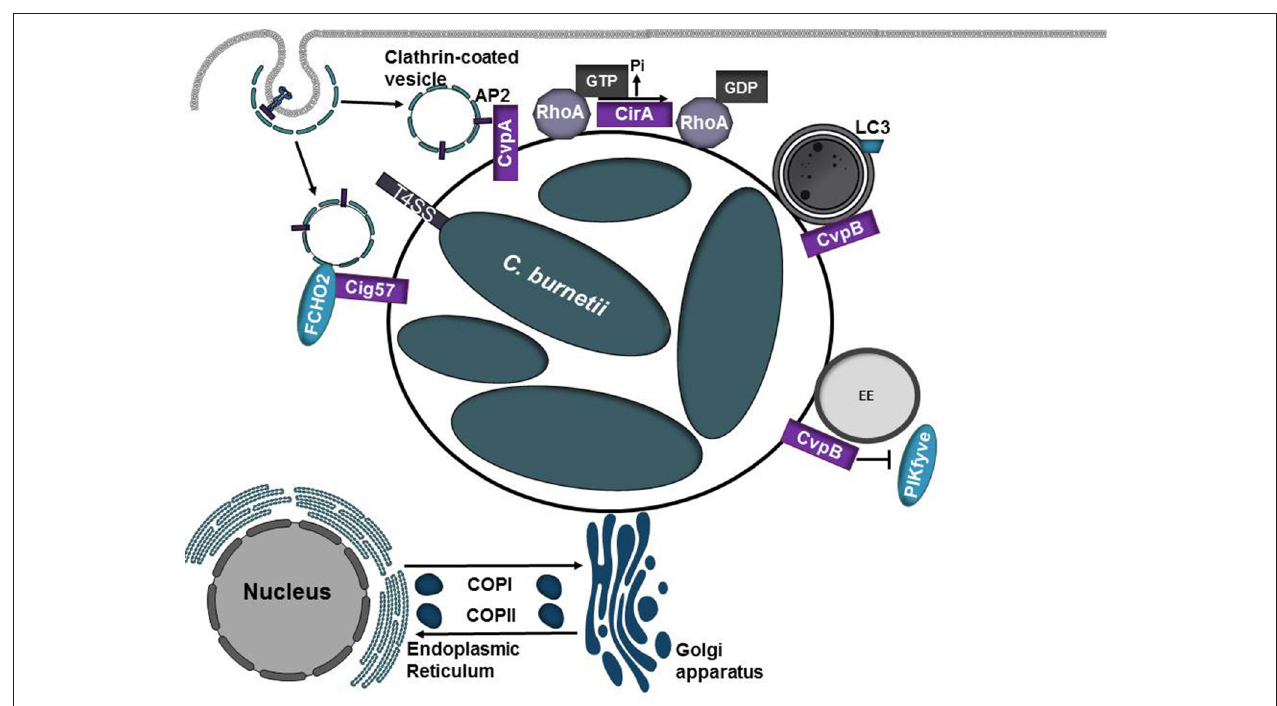
FIGURE 3 | Diverse roles of C. burnetii T4SS effector proteins. Coxiella burnetii replicates in an acidic phagolysosome-like compartment termed the Coxiella- containing vacuole (CCV). Acidification of the CCV promotes activation of the Dot/Icm type IV secretion system (T4SS) which translocates over 130 proteins into the eukaryotic host cell. As the CCV matures, it undergoes fusions with autophagosomes and acquires the autophagosomal maker LC3. CvpA and Cig57 modulate clathrin-dependent vesicular transport pathways through interactions with adaptor protein 2 (AP2) or FCHO 2 , respectively. CirA acts as a GTPase activating protein (GAP) for RhoA. CvpB/Cig2 promotes CCV expansion by targeting endosomes and autophagosomes. CvpB/Cig2 interferes with PI 5-kinase PIKfyve access to early endosomes, resulting in increased levels of PI(3)P on